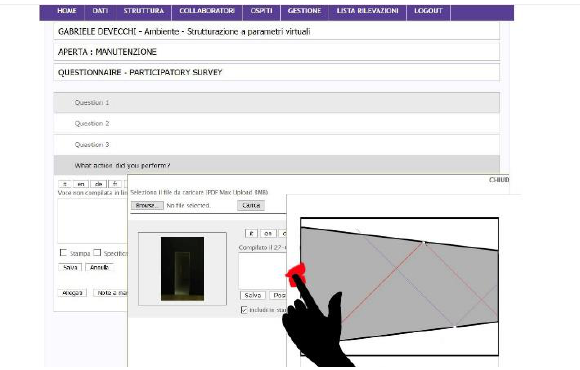
Fig.5. A way for visitors to use the